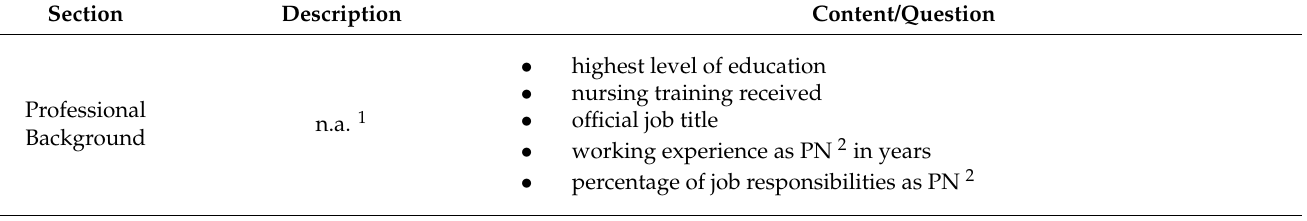
Table 1. Structure of the